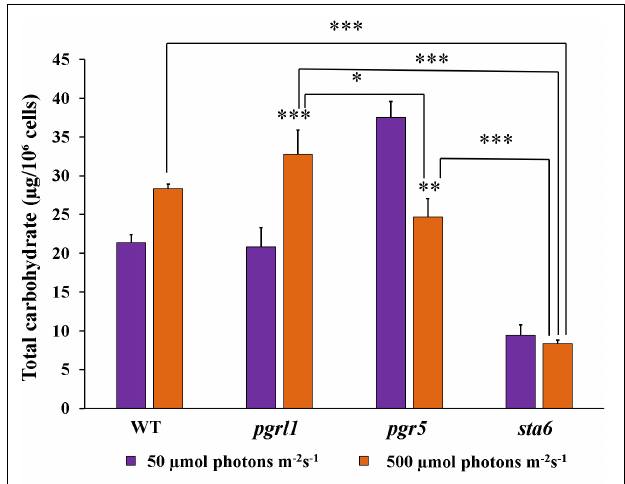
FIGURE 7 | Total carbohydrate content quantified by Anthrone method from the cells grown under normal to high light conditions. Cells were collected at the mid-log phase from normal (50 µ mol photons m − 2 s − 1 ) and high (500 µ mol photons m − 2 s − 1 ) light conditions. The color was measured with spectrophotometry at 620 nm. Three biological experiments were done ( n = 3), and error bars represent the mean ± SD ( n = 4). Statistical significance was analyzed using one-way ANOVA with Tukey test and p -value obtained are indicated ( ∗∗∗ p < 0.001, ∗∗ p < 0.01, ∗ p <